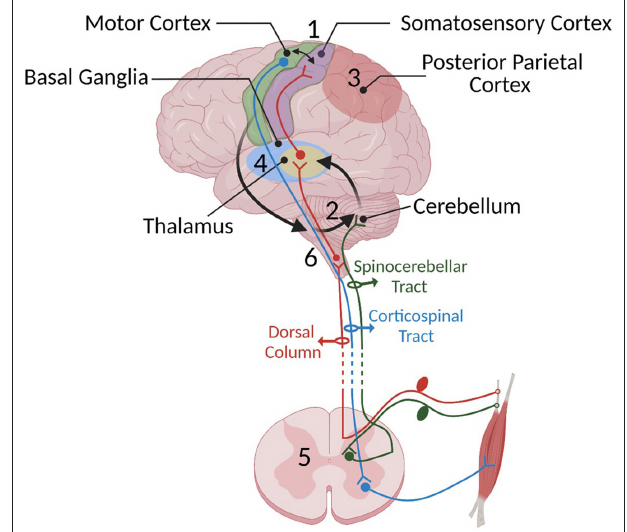
FIGURE 1 | Some of the important SMI centers and their connections mentioned in Part 1: (1) the sensorimotor cortex, (2) cerebellum, (3) posterior parietal cortex, (4) basal ganglia, (5) spinal cord, and (6) brainstem. Sensory information travels to the spinal cord via sensory afferents and then is relayed to the sensory centers in the cortex, thalamus, and cerebellum through the dorsal medial lemniscus (shown in red) and spinocerebellar pathway (shown in dark green), respectively. We have chosen not to show the spinothalamic pathway since it has not yet been shown to be crucial to SMI. The cerebellum constantly receives somatosensory information and integrates these senses with an efference copy of motor commands relayed through pontine nuclei located in the brain stem (shown with black arrows) to estimate the sensory consequences of movements. In turn, it provides feedback to the cortical areas through the thalamus. The motor cortex has loops with different cortical areas including basal ganglia, PPC, cerebellum, and brainstem. Information provided by these loops is used to shape the final motor command and the output is sent to the spinal cord. Descending cortical information synapses either directly with lower motor neurons or spinal interneurons. The motor output travels through the ventral root of the spinal cord to muscles to generate